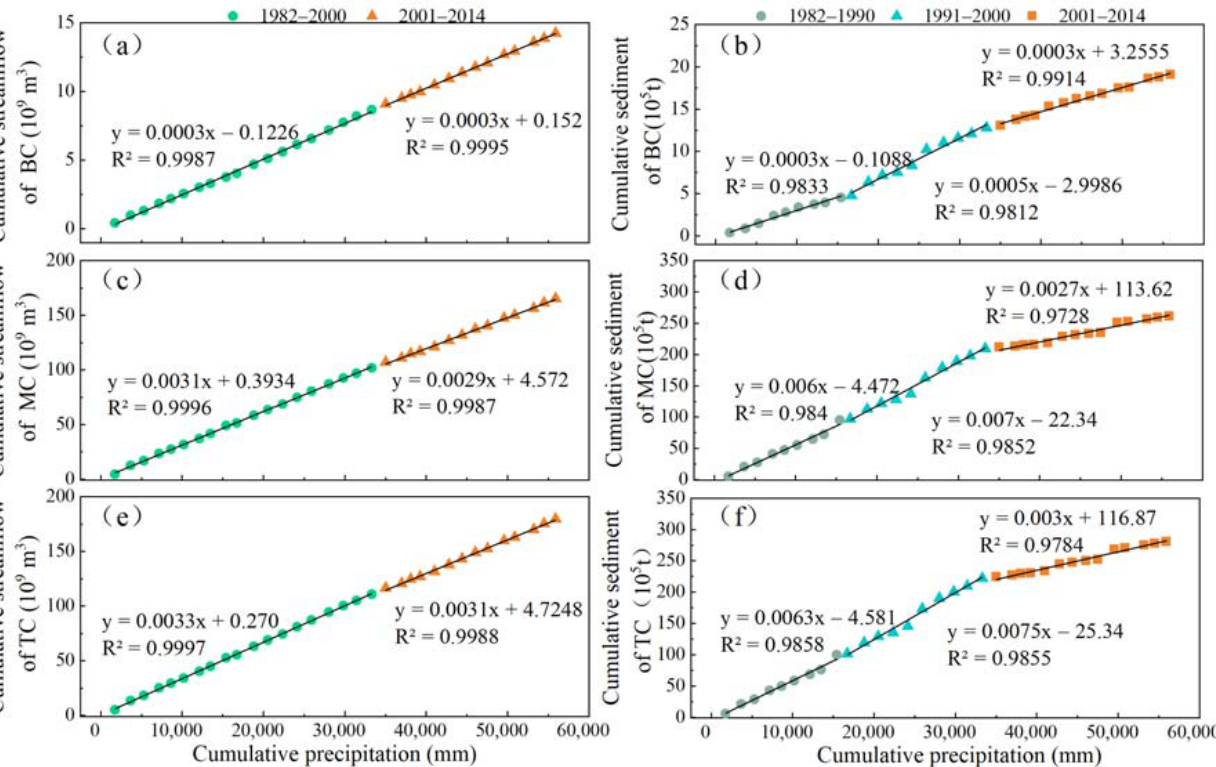
Figure 8. Double mass curves of precipitation–streamflow and precipitation–sediment during 1982–2016 in BW ( a , b ), MW ( c , d ), and TW ( e , f ), respectively.